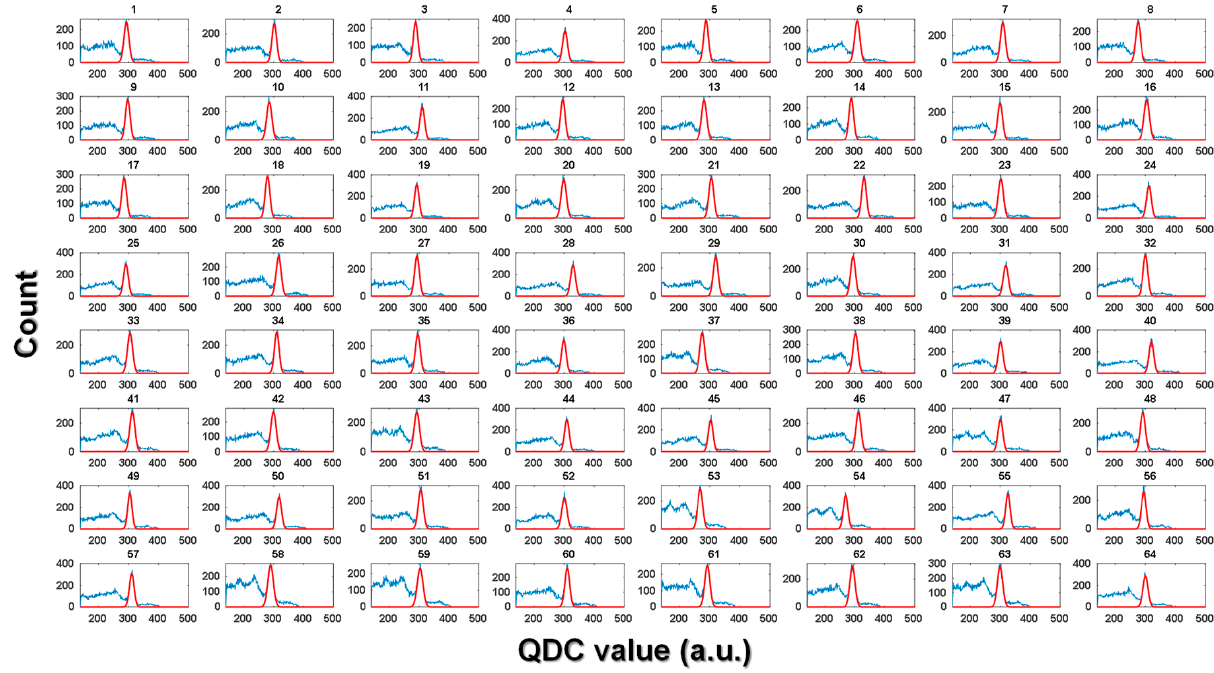
Figure 10. Representative energy spectra acquired from 64 channels of the TOF brain PET. The thick solid lines were the result of applying a Gaussian fit to the photopeak position corresponding to 511 keV.